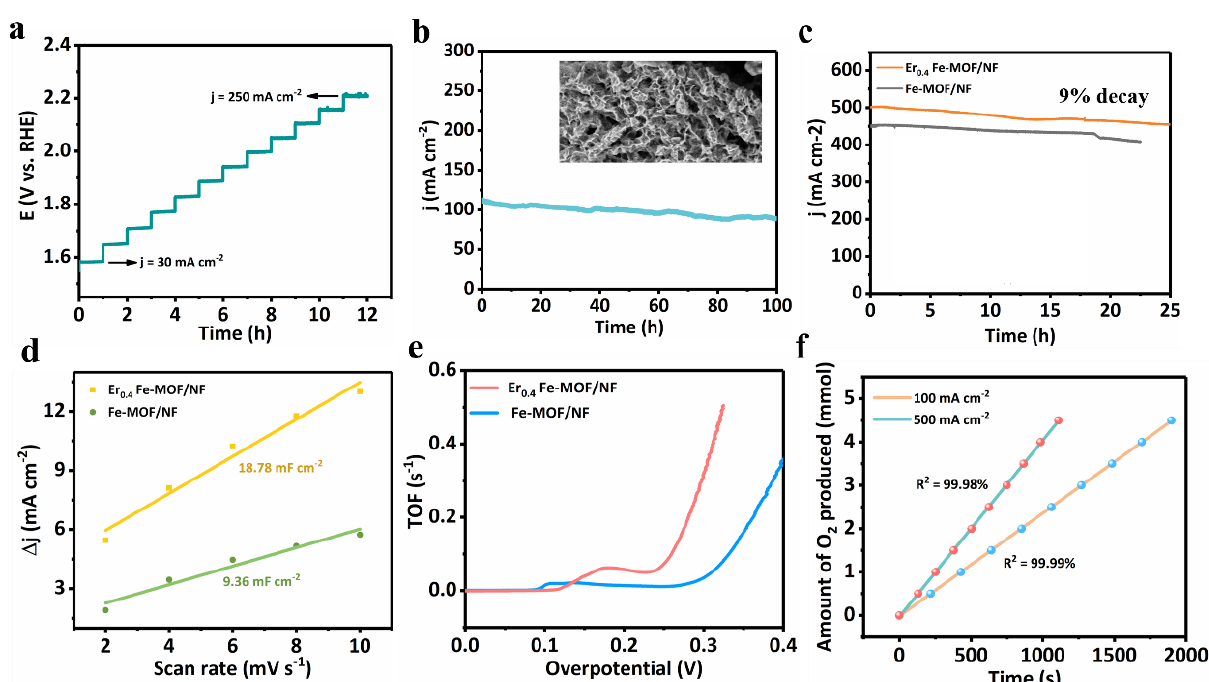
Figure 4. The multi-current process curve of Er 0.4 Fe - MOF/NF ( a ) obtained at current densities of 30–250 mA cm − 2 , every 3600 s, respectively. Chronoamperometric (i-t) curves at current densities of 100 mA cm −2 ( b ), inset was the SEM image after testing. Chronoamperometric curves of Er 0.4 Fe - MOF/NF and Fe - MOF/NF ( c ). ECSA evolutions ( d ) and TOF values ( e ) of Er 0.4 Fe - MOF/NF and Fe - MOF/NF. Experimental amounts of O 2 generated by the Er 0.4 Fe - MOF/NF electrode at 100 and 500 mA cm −2 ( f ).